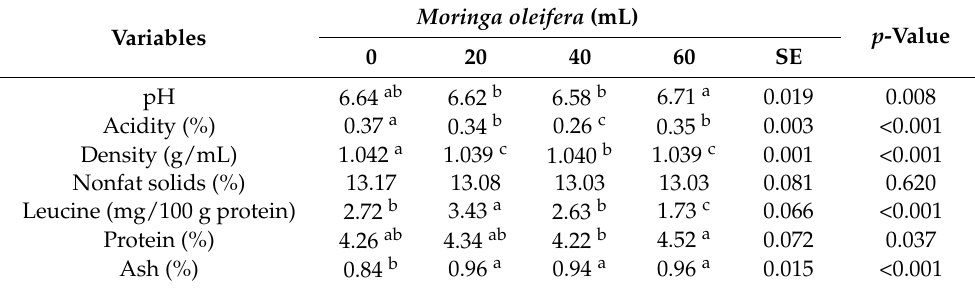
Table 1. Chemical and physical composition of milk from sheep fed with Moringa oleifera